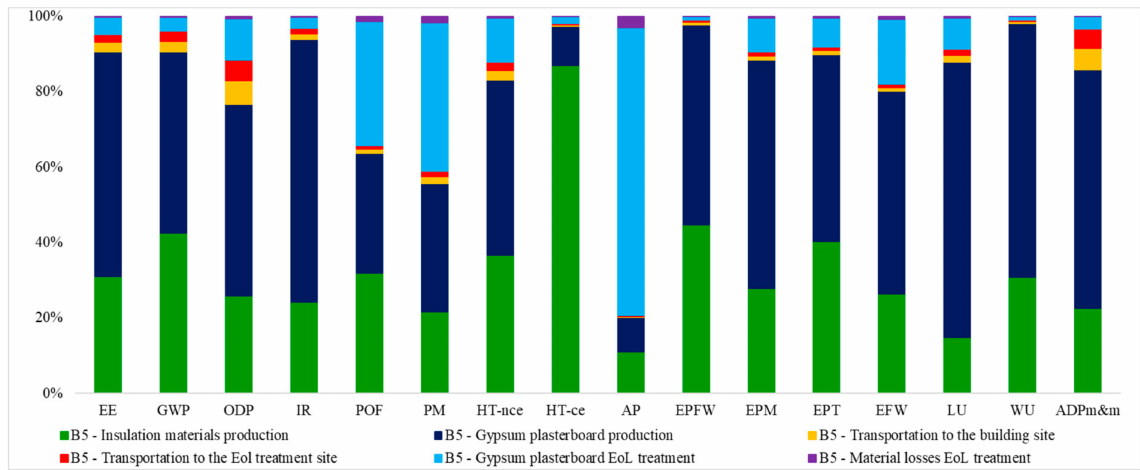
Figure 5. Contribution of the different life cycle phases to the B5 module impacts—SwS